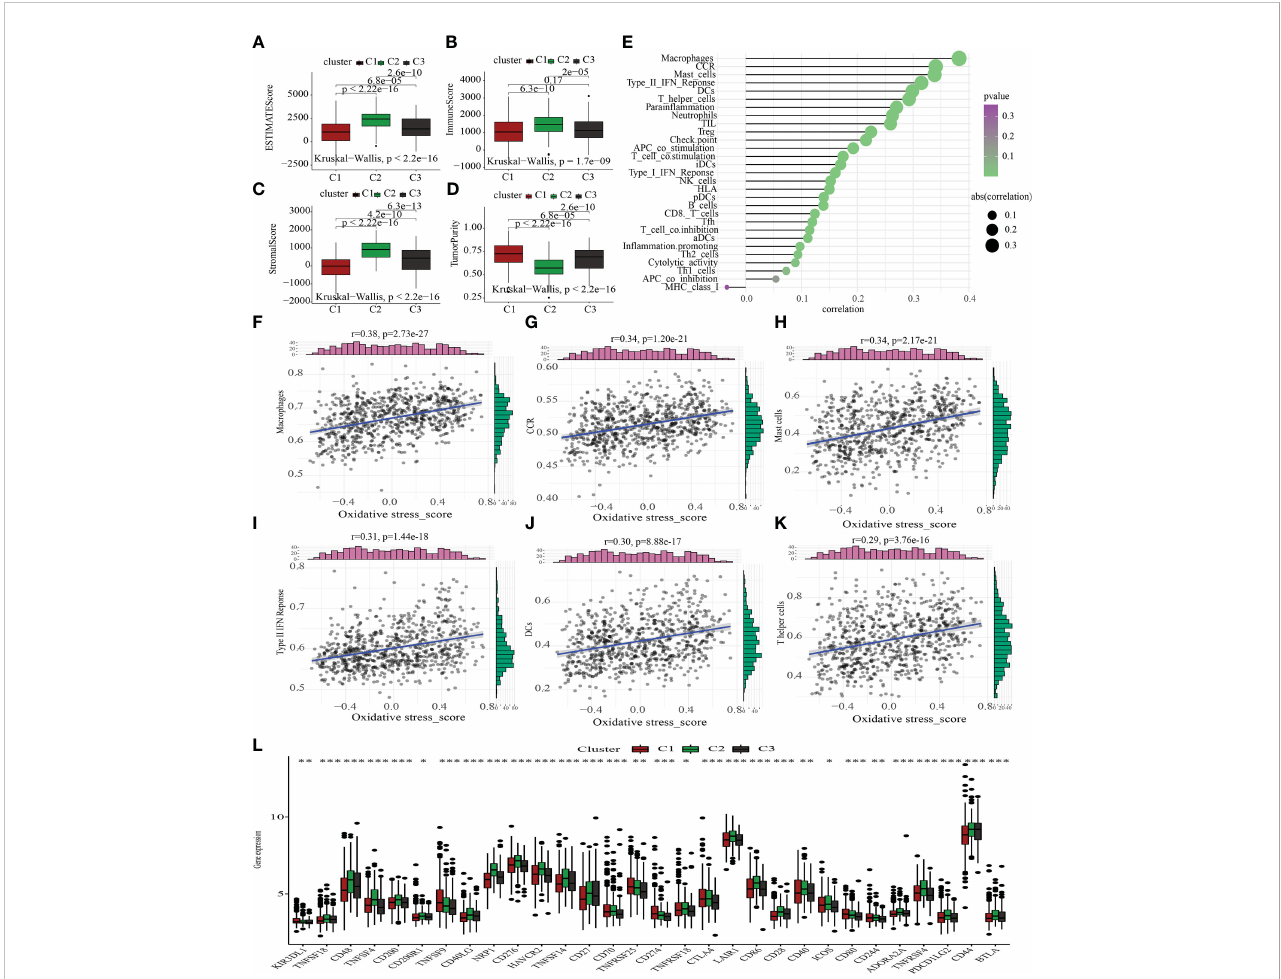
FIGURE 5 Comparative immunological status examination of two molecular groups. (A-D) Comparative analysis of the TME components. (E) The plot illustrates the link between the score for oxidative metabolism and the in fi ltration of immune cells. (F-K) The scatter fi gure illustrates the link between the oxidative metabolism score and six substances associated with immune in fi ltration. A favorable correlation was identi fi ed between the oxidative metabolism score and the in fi ltration of macrophages, CCR, mast cells, type II IFN response, DCs, and T helper cells. (L) Comparison of the three subtypes ’ immune checkpoint gene expression using a differential analysis method. *P < 0.05; **P < 0.01; ***P <